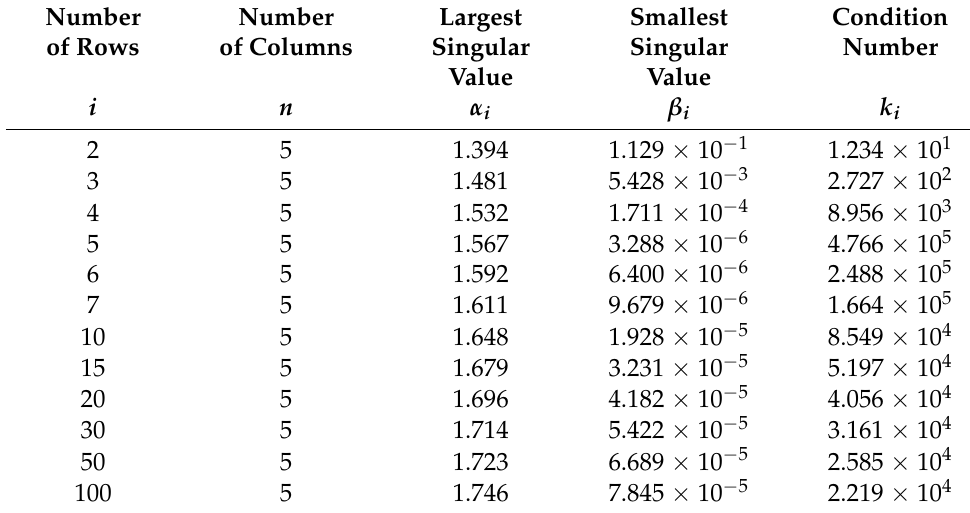
Table 2. The anomaly in small Hilbert